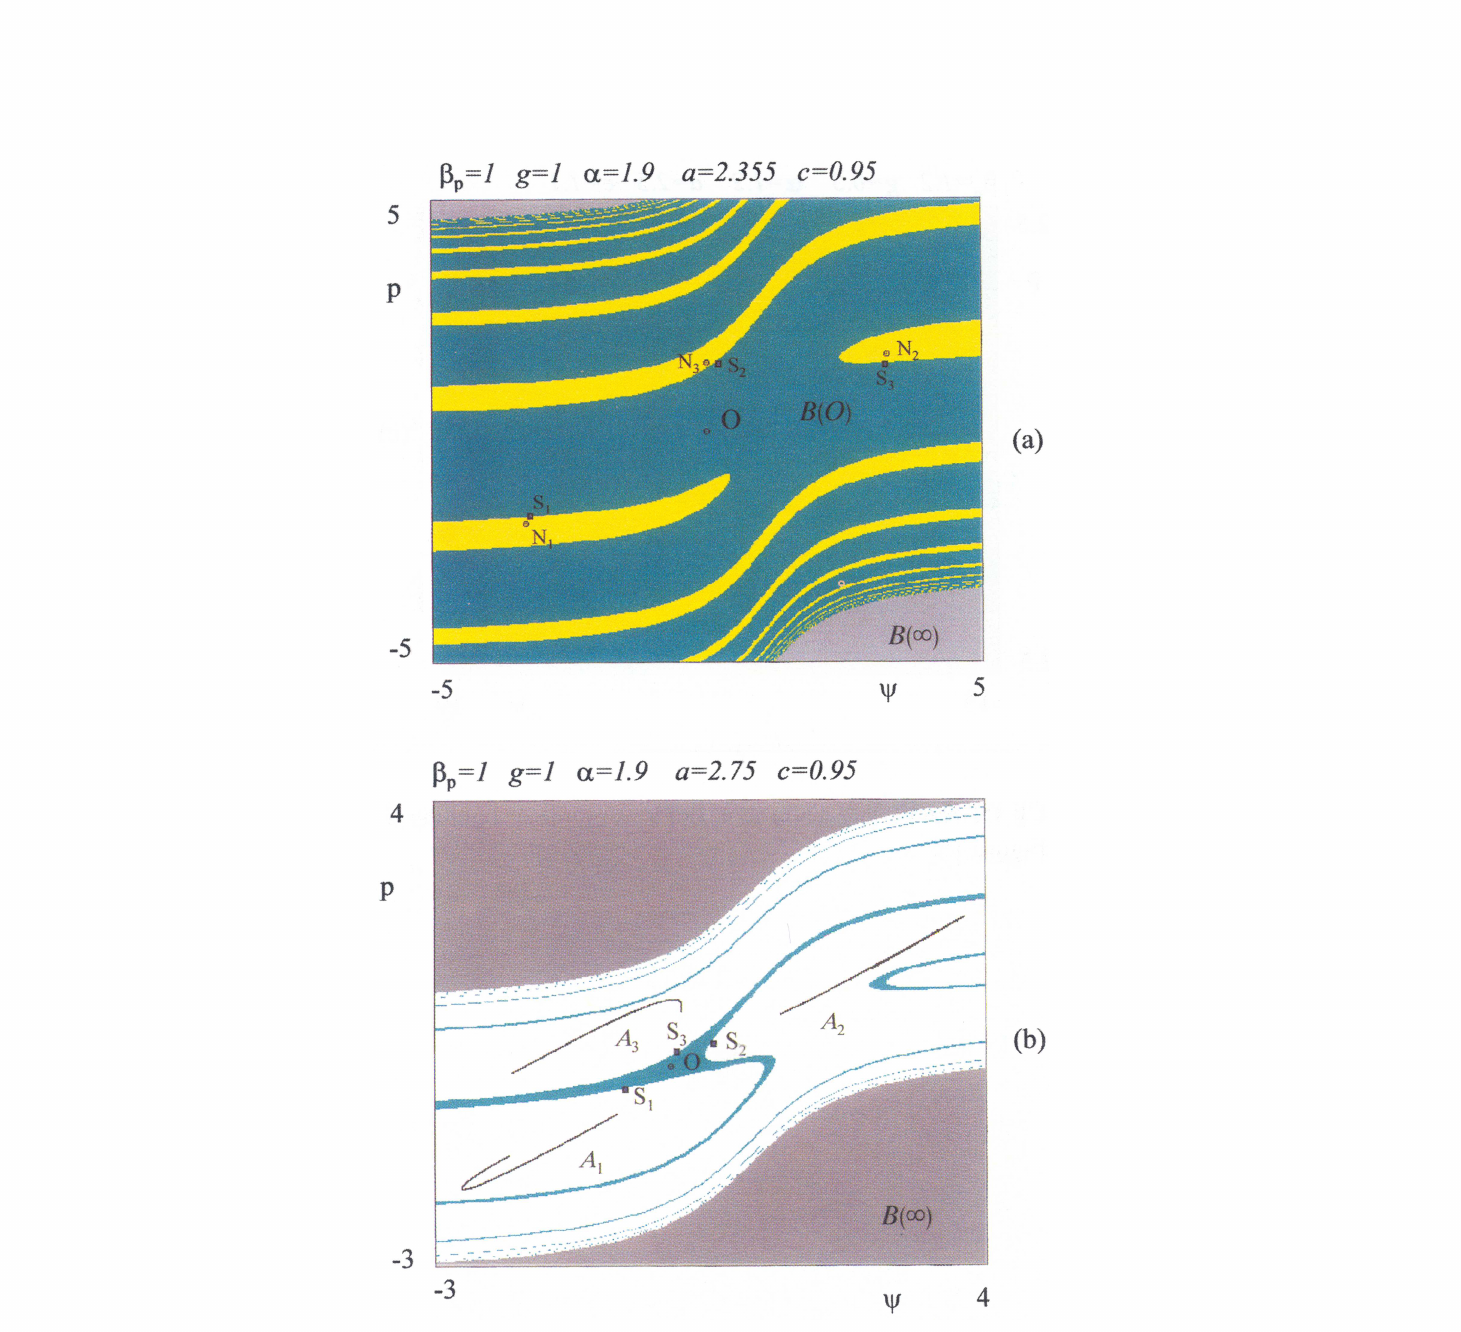
FIGURE 15 The phenomena of persistent coexistence of attracting sets, observed by increasing a further from the situation represented in Figure 14b (where c- 0.95, tip- 1, g-- 1, c 1.9). After the disappearance of the 4-cycle represented in that figure, a new competing attracting set appears, a 3-cycle C3 shown in (a), at a= 2.355, whose basin becomes much wider than B(O). This 3- cycle undergoes a flip-bifurcation sequence, which finally transforms it into a 3-piece chaotic attractor, as shown in (b) for a 2.75. _ This attracting set increases in size, and it approaches the boundary of its basin, as shown in (c), obtained for a--2.84675. The enlargement in (d) shows that a "contact bifurcation" or "crisis" is about to occur, destroying the chaotic attracting set, leaving O as the only attractor but leaving also a chaotic repellor in the region of bounded trajectories. The effect of the presence of this chaotic repellor on the transient part of the trajectories is shown in (e), where a-- 3.2225. By increasing a further, the observed sequence of global bifurcations also occurs in a "backward" way: a reverse contact bifurcation transforms again the chaotic repellor into a 3- piece chaotic attractor: see (f), obtained for a 3.225. It undergoes a sequence of reverse flip-bifurcations, up to the restoration of a 3.363 causes the disappearance of the 3-cycle C3 shown in (g), where a= 3.3. A reverse saddle-node bifurcation occurring at a competing 3-cycle, leaving again the fixed point O as unique attracting set, but now with a smaller basin than the one observed for low values of a. By increasing a further, a flip bifurcation "replaces" the attracting fixed point with an attracting 2-cycle represented in (h) for a= 3.9196, whose basin is however reduced to a narrow strip. (See Color Plate